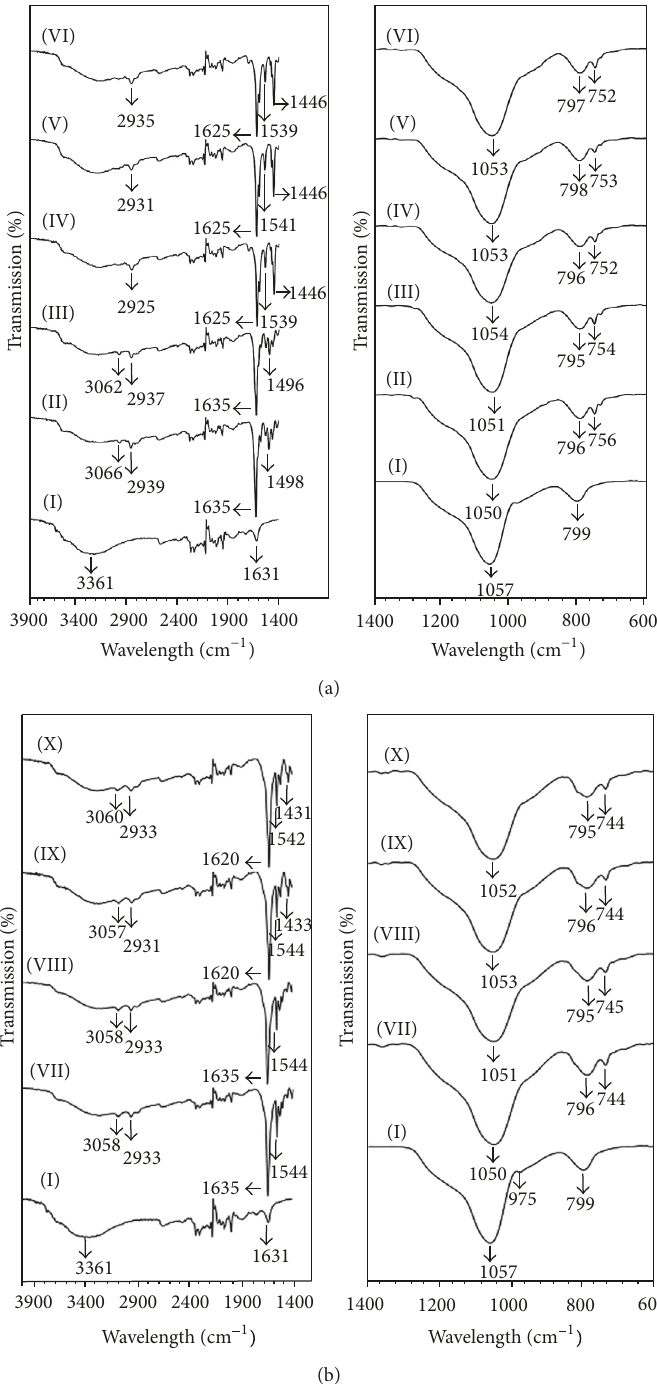
Figure 1: (a) FT-IR of (I) SiO 2 , (II) SiO 2 @ imineSA, (III) SiO 2 @ imineSB, (IV) SiO 2 @ imineSA-Pd-II, (V) SiO 2 @ imineSB-Pd-II, and (VI) SiO 2 @ imineSA-Pd-II. (b) FT-IR of (I) SiO 2 , (VII) SiO 2 @ imineNA, (VIII) SiO 2 @ imineNB, (IX) SiO 2 @ imineNA-Pd-II, and (X) SiO 2 @